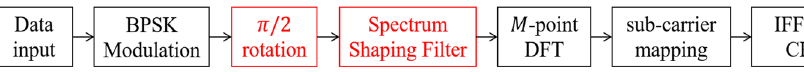
Fig. 4 Implementation of π/ 2 -BPSK with spectrum shaping